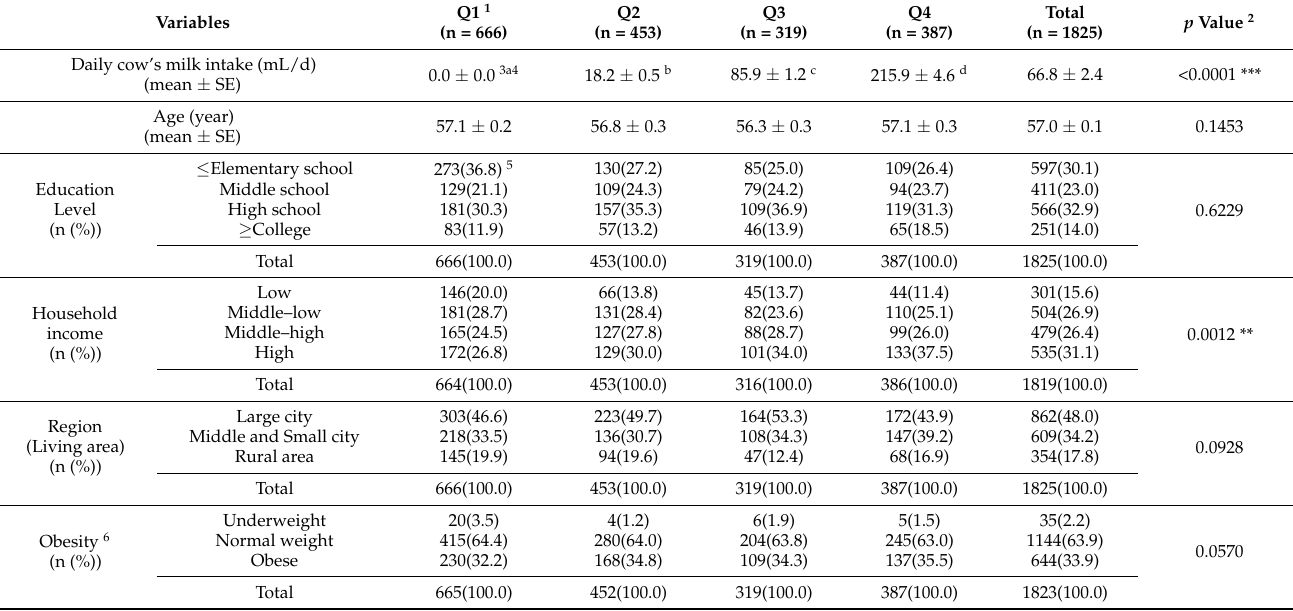
Table 1. The general characteristics of the subjects according to cow’s milk intake frequency.